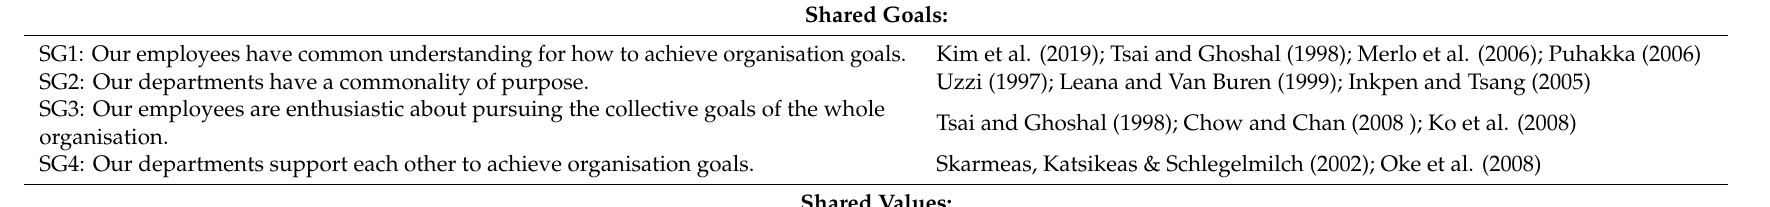
Table A2. Cognitive Capital Dimensions. Shared